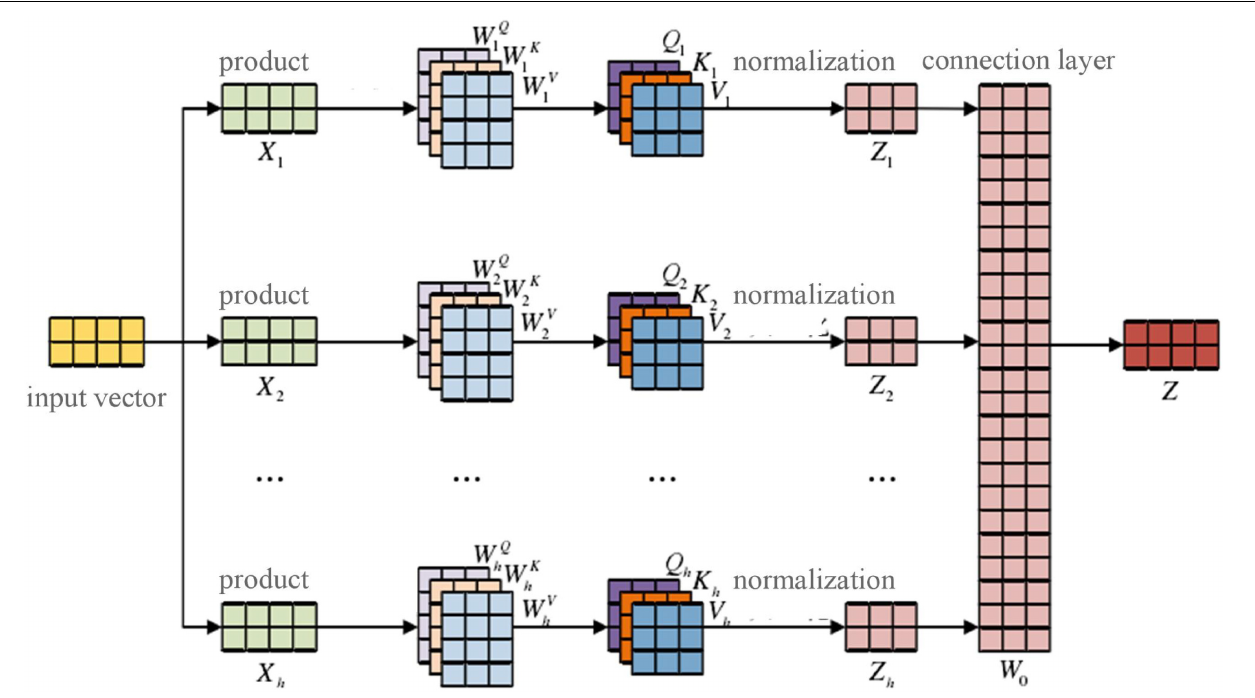
FIGURE 5 | Semantic feature extraction based on the multi-attentional mechanism.